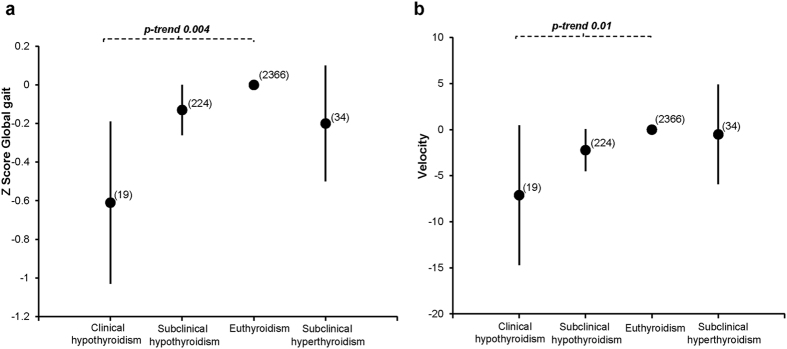
Association of thyroid status categories with Global gait and velocity.Adjusted for age, sex, cohort, smoking, alcohol intake, education level, height, weight, time interval between thyroid function measurement and gait assessment, knee pain or stiffness, hip pain or stiffness, prevalent stroke, CESD depression score, cerebellar cortical volume, intracranial volume, thyroid peroxidase antibodies. Thyroid status categories are plotted against differences in Z score of Global gait and velocity, with euthyroid subjects as reference. Euthyroidism was defined as TSH (thyroid-stimulating hormone) within reference range (0.4–4.0 mIU/l); clinical hypothyroidism as TSH > 4.0 mU/L and FT4 (free thyroxine) <11 pmol/L; subclinical hypothyroidism as TSH > 4.0 mU/L and FT411-25 pmol/L; clinical hyperthyroidism as TSH < 0.4 mU/L and FT4 > 25 pmol/L; subclinical hyperthyroidism as TSH < 0.4 mU/L and FT411-25 pmol/L. None of the participants had clinical hyperthyroidism. Error bars represent the 95% confidence intervals around the standardized β (black dots). Within brackets: Total number. A higher value of global gait represents better gait.